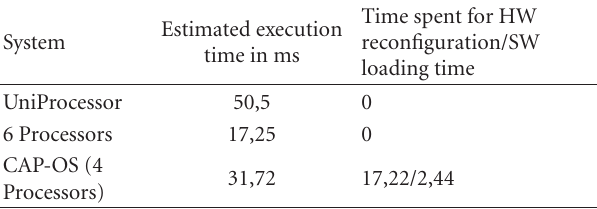
Table 8: Estimated execution times for the